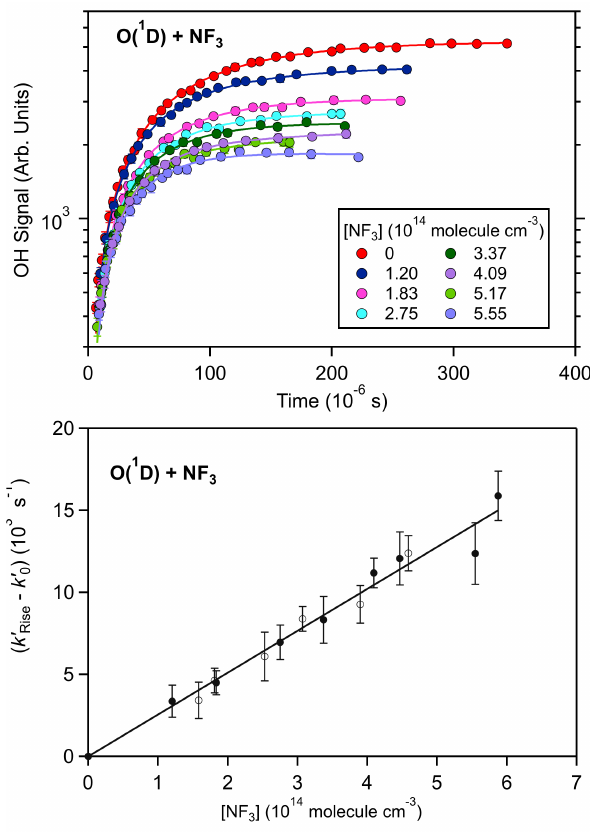
Fig. 1. O( 1 D) + NF 3 reaction kinetic data obtained using the com- petitive reaction method (see text for details). Top Panel: Represen- tative OH temporal profiles obtained at 296K and 35Torr (He) for a range of NF 3 concentrations as given in the legend. The 2 σ error bars on the data points are from the measurement precision. The O 3 concentration was 3.9 × 10 12 moleculecm − 3 and [ n -C 4 H 10 ] = 1.3 × 10 13 moleculecm − 3 . The lines are non-linear least-squares fits of the OH temporal profiles (see text). Bottom Panel: Pseudo- 0 − k 0 first-order rate coefficient data, k , obtained in 2 indepen- Rise 0 dent experiments. The error bars are the 2 σ uncertainties from the OH temporal profile fits. The line is a linear least-squares fit of the data. The results are given in Table